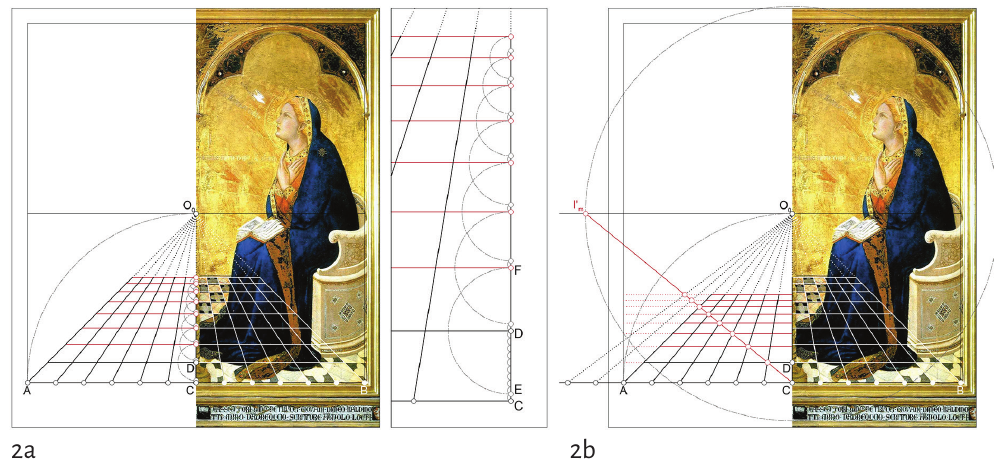
Figure 2 Deduction of the rule used by Lorenzetti for the degradation of depths and comparison with the construction of the same subject carried out in a rigorous way. Author’s